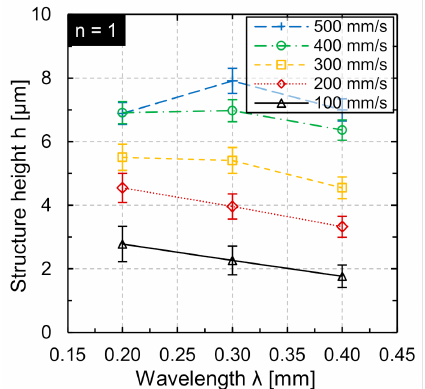
Figure 13. Structure height as function of wavelength λ for different scan speeds v scan at adapted track offsets dy for areal structuring ( d L = 50 µ m, v scan = 200 mm/s, P M and P A adapted to v scan ).